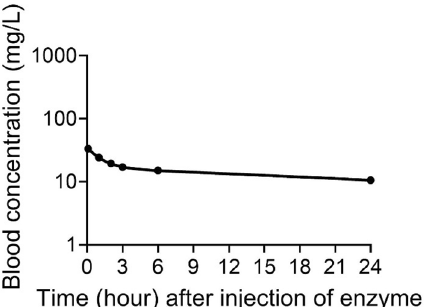
Figure 7. Serum concentration of CocH5-Fc(M6) after IV administration of 1 mg/kg CocH5-Fc(M6) in rats (n = 4).